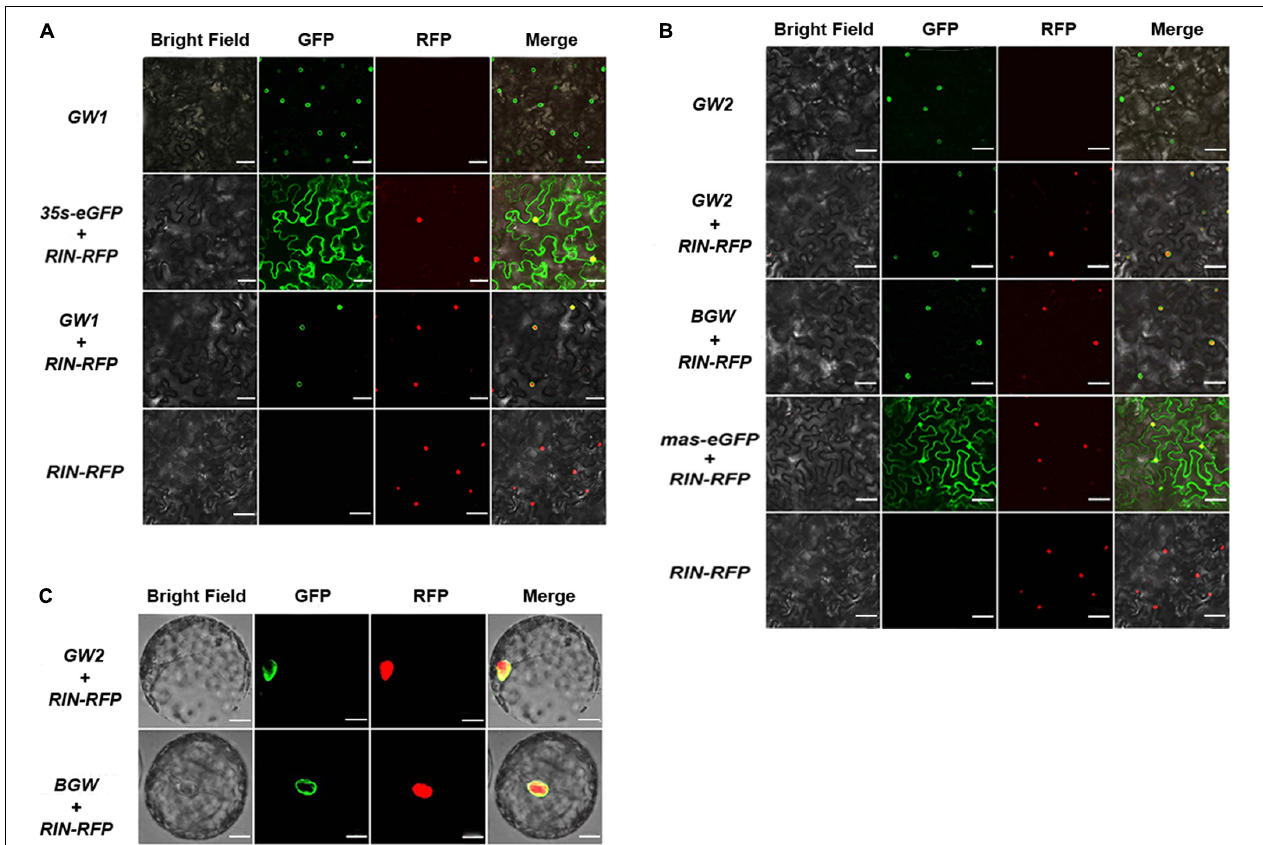
FIGURE 2 | Subcellular localization of three Sl NTFs in tobacco. Different Sl NTF proteins were transiently overexpressed in tobacco leaves (A,B) and protoplast (C) . p35S:RIN-RFP was used as a positive control for nuclear localization, and a negative control (NC) was designed with p35S:eGFP and pmas:eGFP . Scale bars: A and B, 100 µ m; C, 20 µ